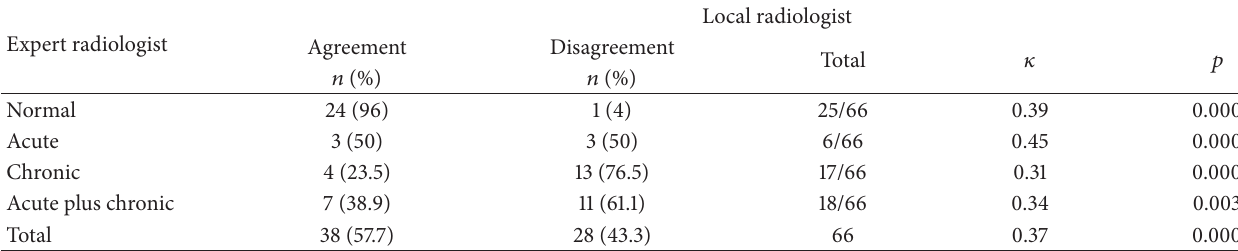
Table 2: Interobserver agreement between local radiologist and expert